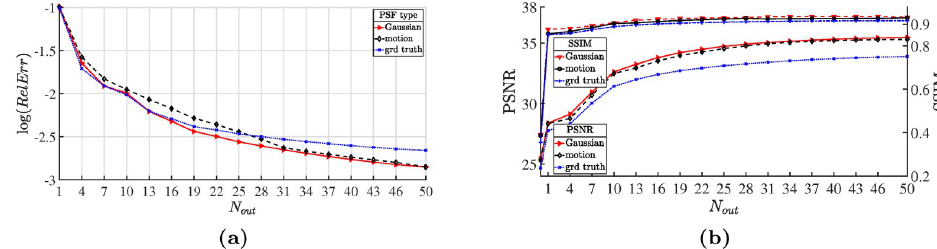
Fig 5. Plot of performance along the HTVp-OGS iterations for restoring “lotus” images blurred by different kernels and corrupted by the Poisson noise of level MAX f = 200. (a) relative error in log scale; (b) PSNR and SSIM